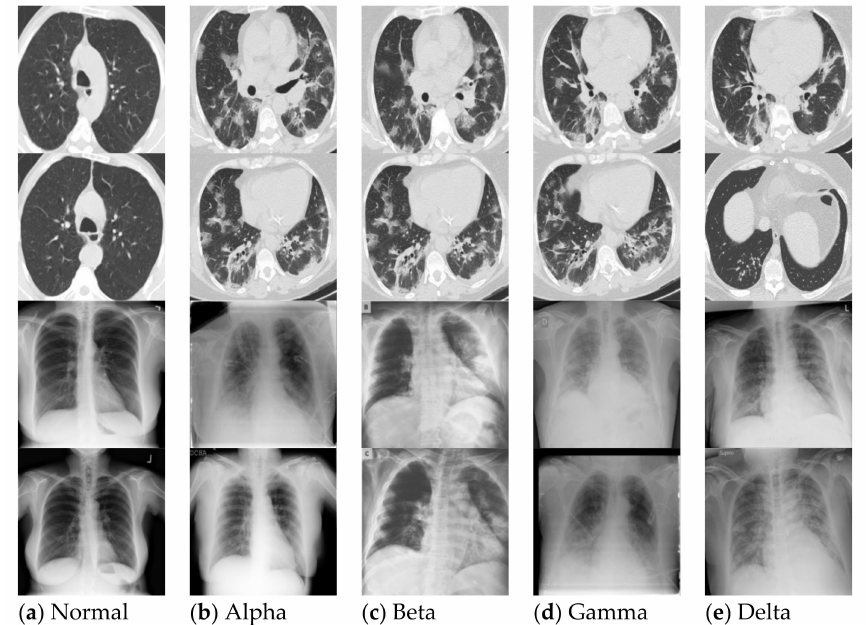
Figure 7. Sample CT scan and X-ray images of the database of different variants ( a ) Column of normal samples; ( b ) Column of alpha variant of COVID-19 samples; ( c ) Column of beta variant samples; ( d ) Column of gamma variant samples; ( e ) Column of delta variant